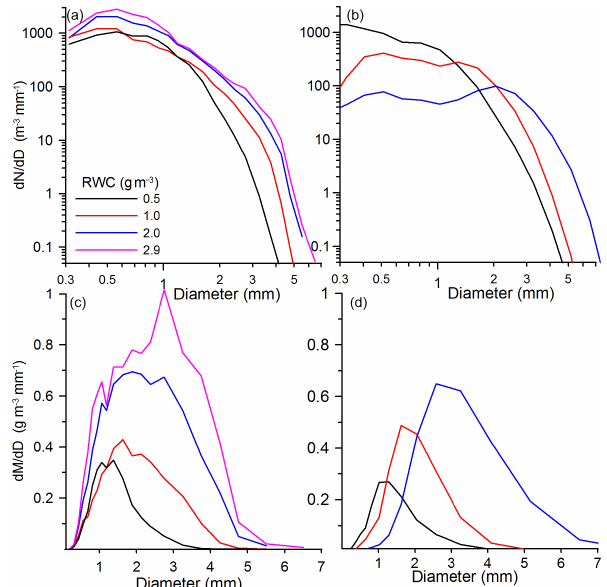
Figure 13. Number distribution functions of raindrops: (a) observed at La Souche in 950ma.s.l., (b) modelled for scenario HymRef. The equivalent mass distributions for the observed spectra are given in (c) and for the modelled spectra in (d) . The spectra were selected in four rainwater categories; each can deviate ± 20% from the given RWC